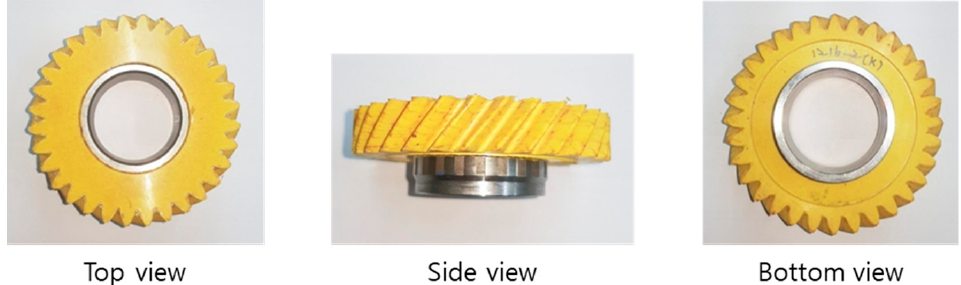
Figure 14. Fabricated WLF helical